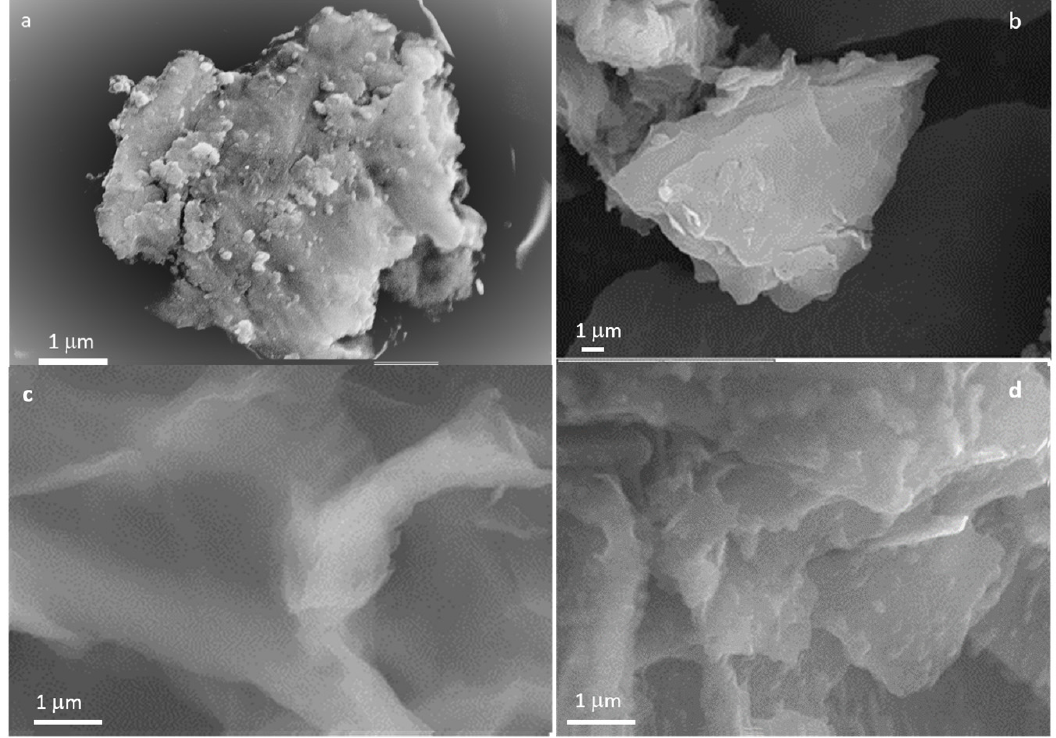
Figure 2. SEM images of ( a ) BSA, ( b ) GO, ( c ) GO-PEG, and ( d ) GO-PEG in BSA.